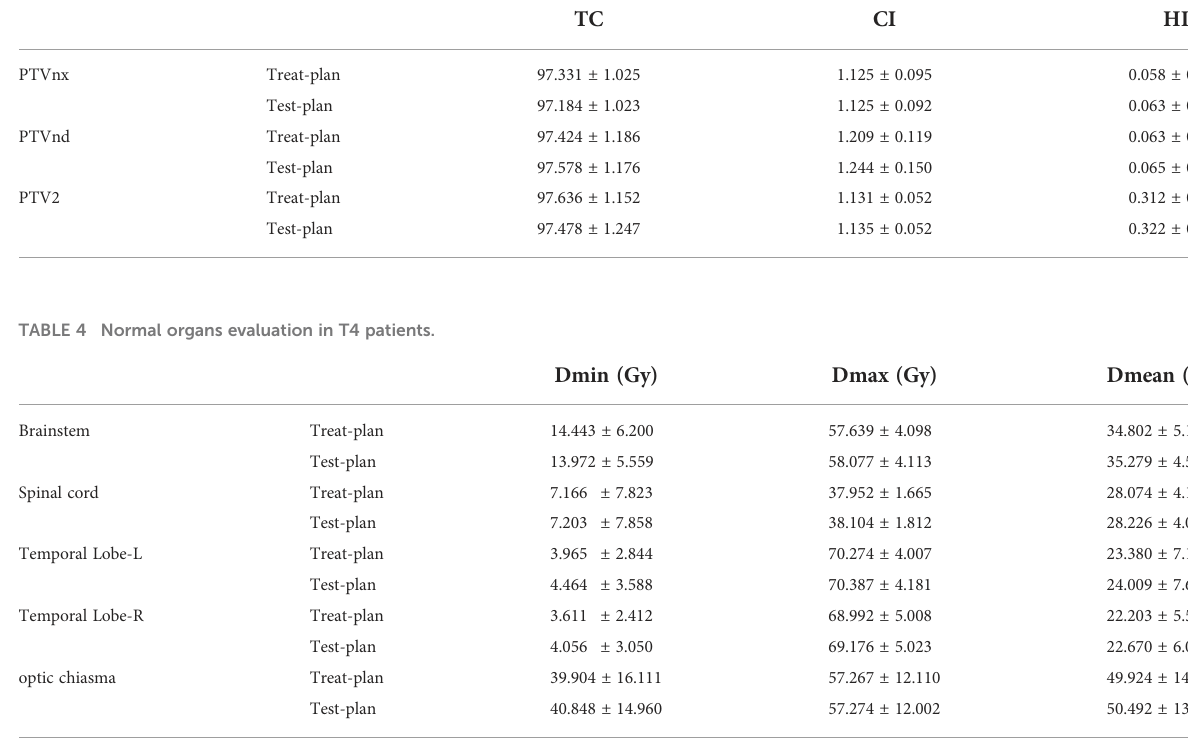
TABLE 3 Target area evaluation in T4 patients.